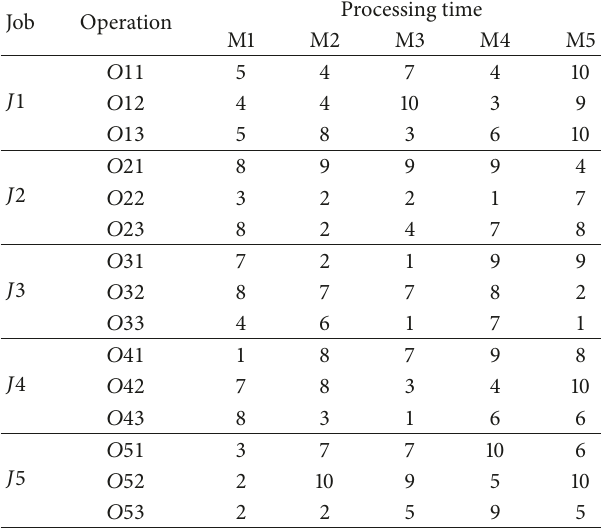
Table 3: Processing information for 5-job and 5-machine FJSP.